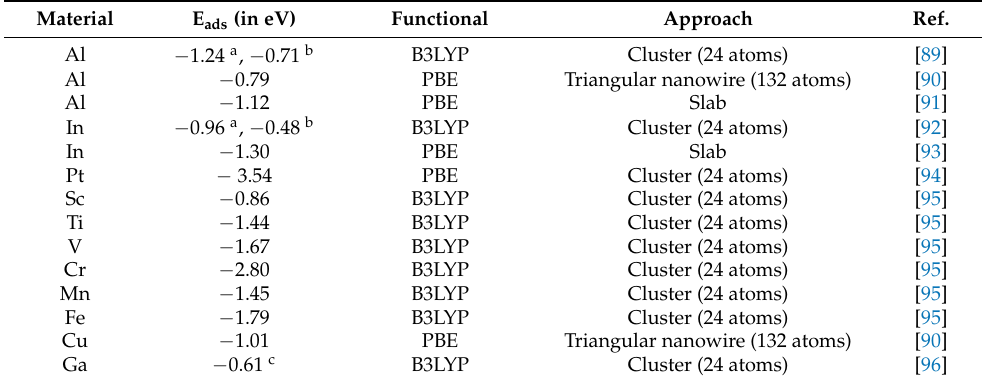
Table 2. Adsorption energies of CO on doped ZnO.